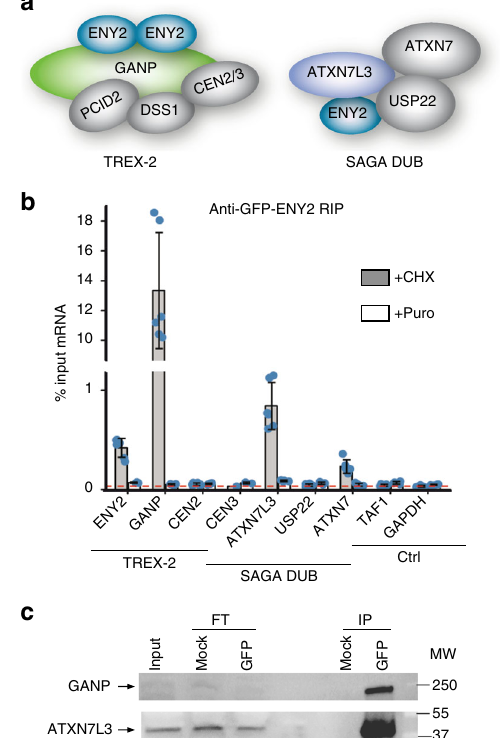
Fig. 8 TREX-2 and SAGA DUB complexes also assemble co-translationally. a ENY2 is shared between TREX-2 and SAGA complex. Two protein molecules of ENY2 binds to the large GANP subunit of TREX-2 complex and ENY2 is also a part of the deubiquitination module of the SAGA complex. b RIP-qPCR of GFP IP from HeLa cell polysome extracts stably expressing GFP-ENY2 tagged at the N-terminus. Error bars represent ±SD from two biological replicates and two technical replicates (represented by blue dots). c Western blot analysis of GFP IP from polysome extract prepared from GFP-ENY2 cell line. Molecular weight (MW) markers are shown in kDa. FT fl ow-through. IP immunoprecipitation. GAPDH was used as unrelated control mRNA. Source data provided as a Source Data